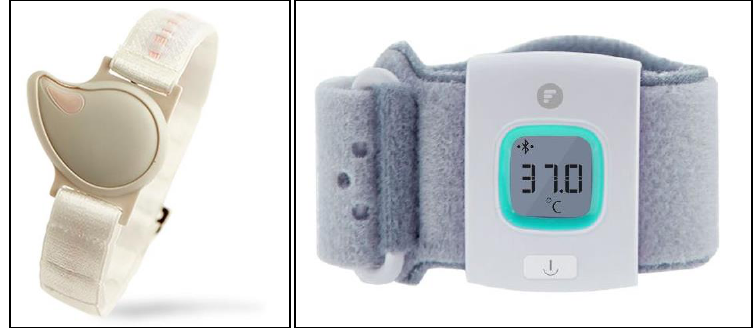
Figure 1. Wearable body temperature assessment devices.